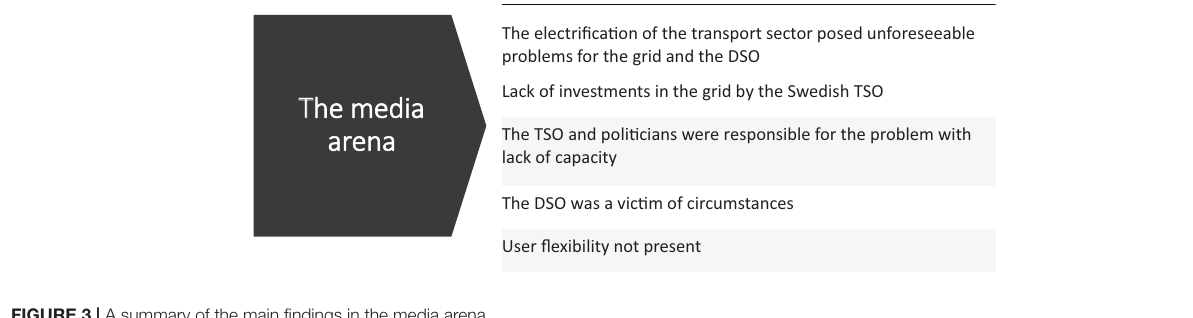
Sweden, Sydsvenskan , reported on a meeting E.ON had organized in which the power balance in the region was discussed.